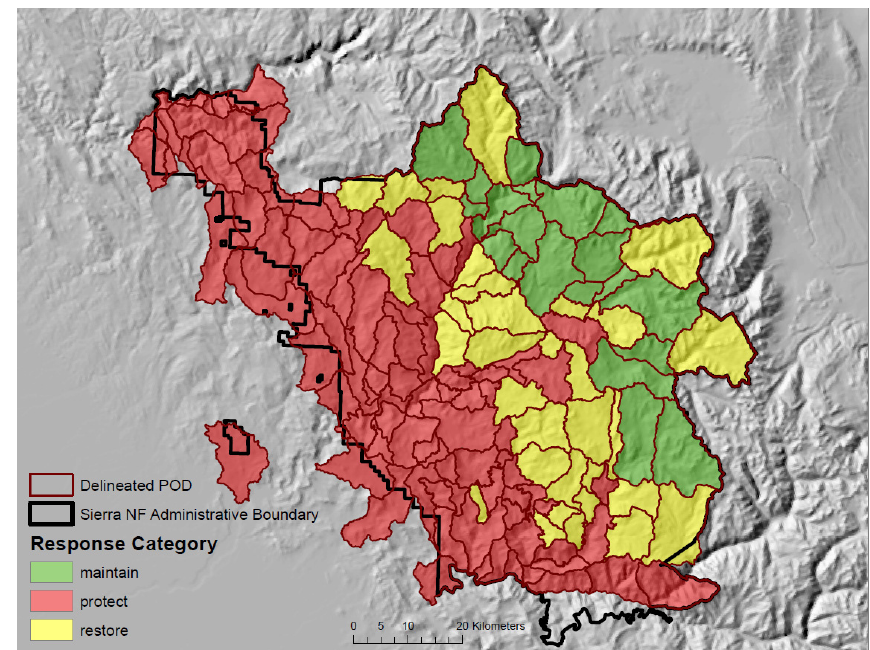
Figure 10. POD ‐ level strategic response category assignments. Figure 10. POD-level strategic response category